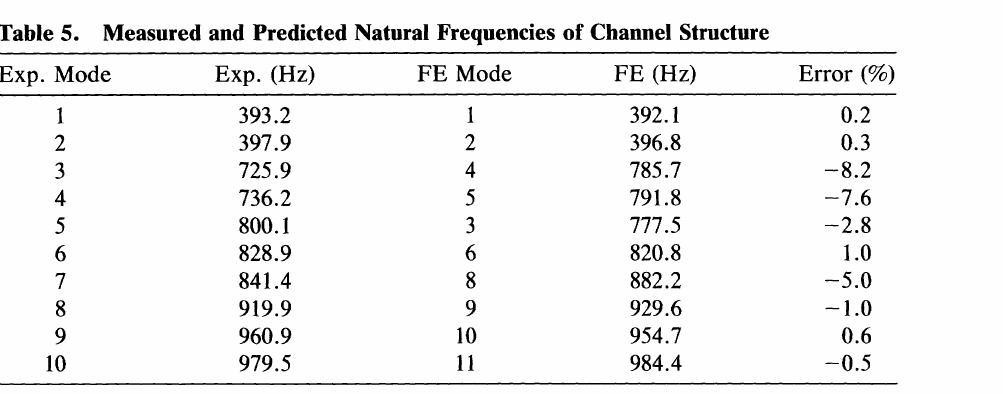
Table 5. Measured and Predicted Natural Frequencies of Channel Structure Exp. Mode